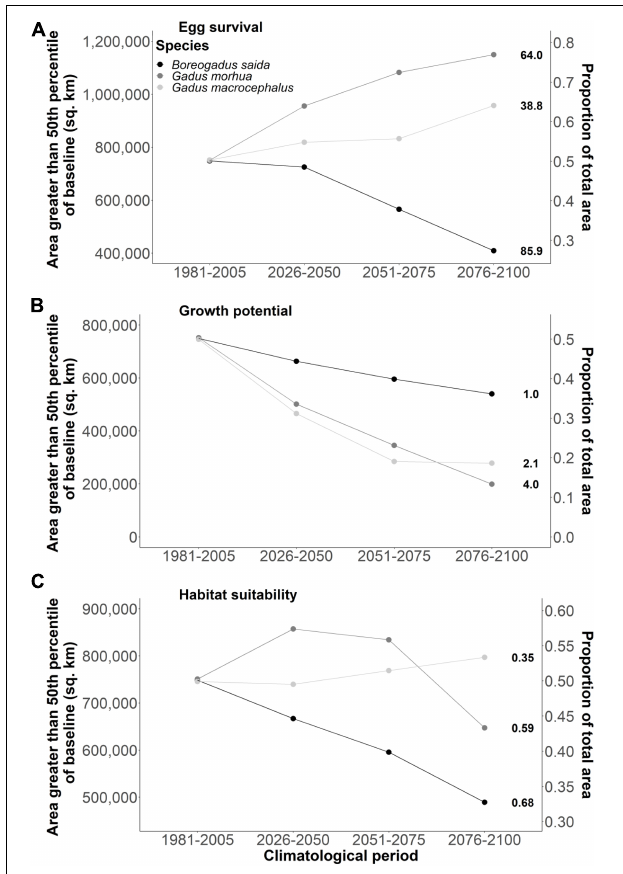
FIGURE 5 | Area (km 2 ) by time period where cell values are greater than the 50 th percentile (threshold noted in bold after the last time point for each species) of baseline values (1981–2005) for egg survival (A) , growth potential (B) , and habitat suitability (C)